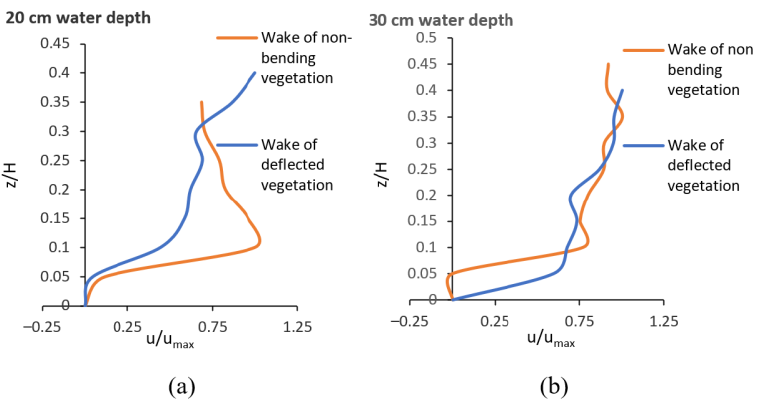
Figure 8. Comparison of velocity profiles in the wake zone behind vegetation elements arranged in a square configuration, ( a ) water depth = 20 cm; ( b ) water depth = 30 cm.